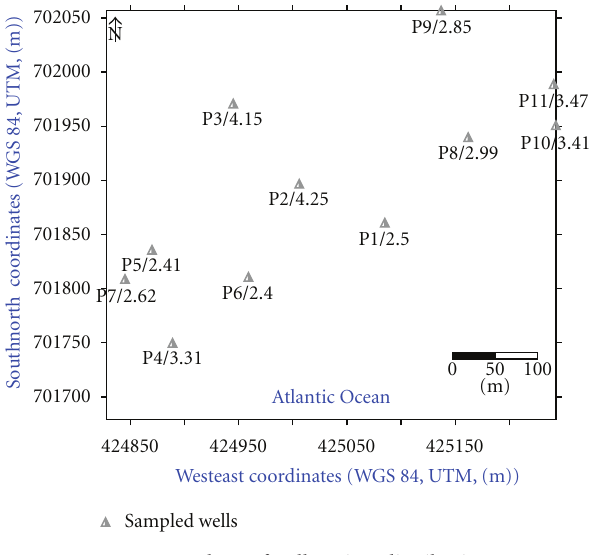
Figure 4: Chart of wells points distribution.